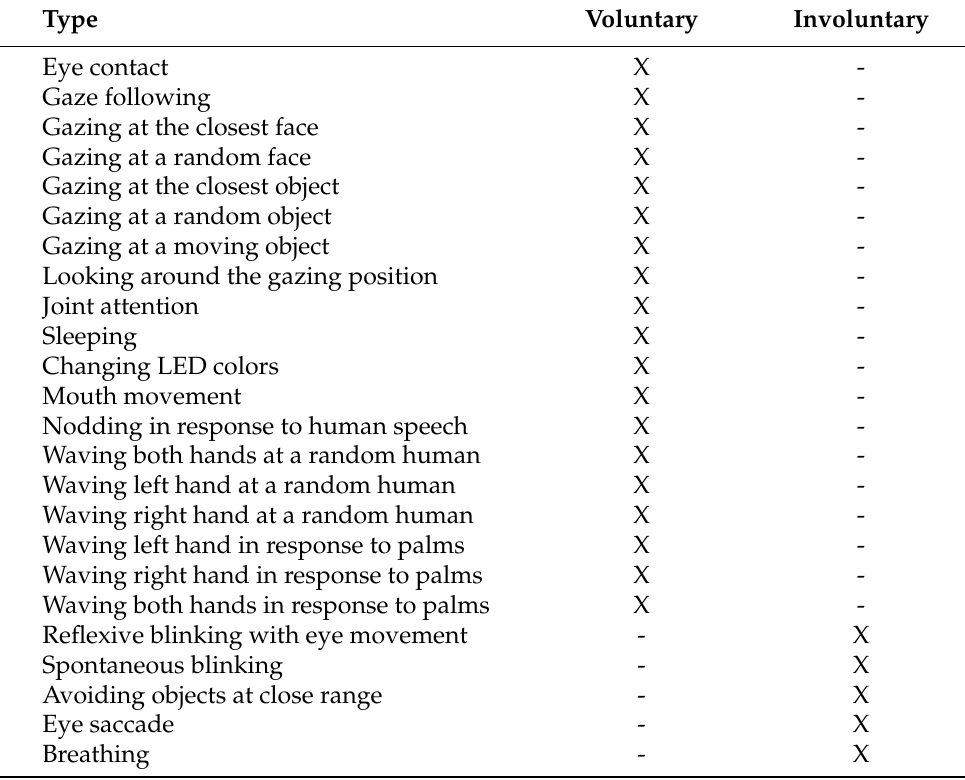
Table 10. Robotic mechanisms to enhance